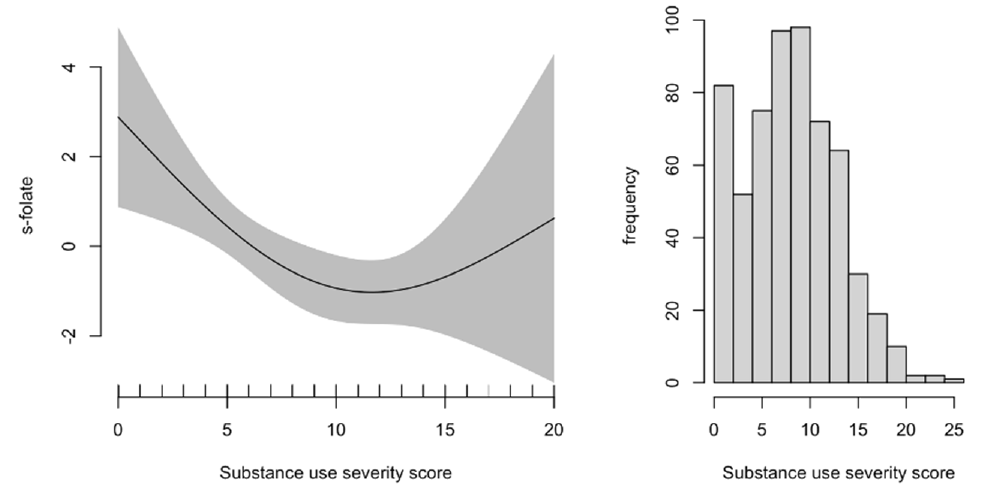
Figure 2. Generalized additive model plot of the association of serum folate concentration with the substance use severity score.